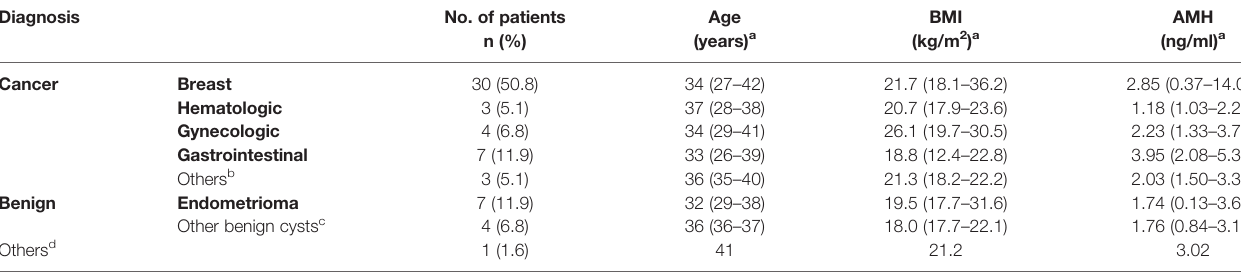
TABLE 3A | The characteristics of patients who underwent embryo cryopreservation (n = 59).